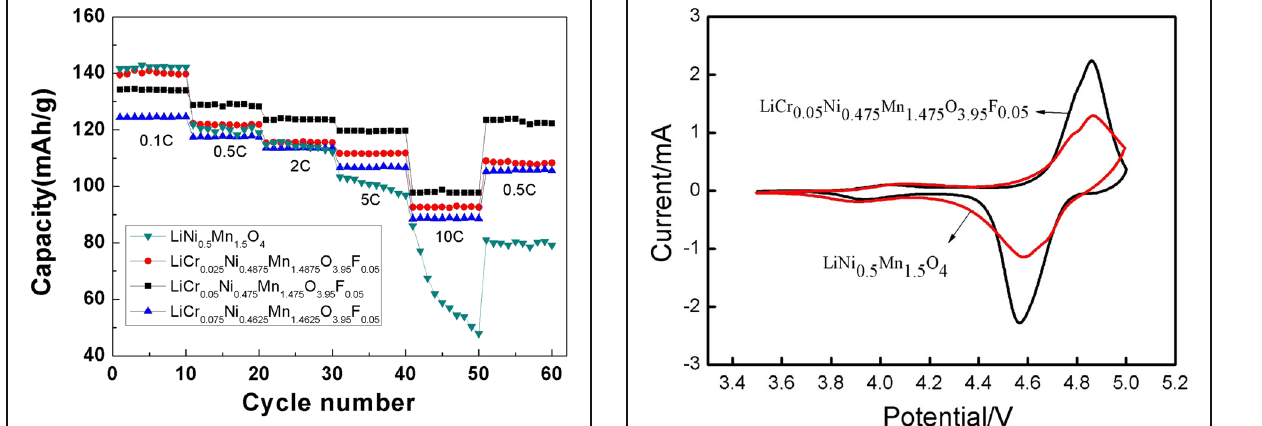
Fig. 8 Cyclic voltammogram of LiNi 0.5 Mn 1.5 O 4 and LiCr